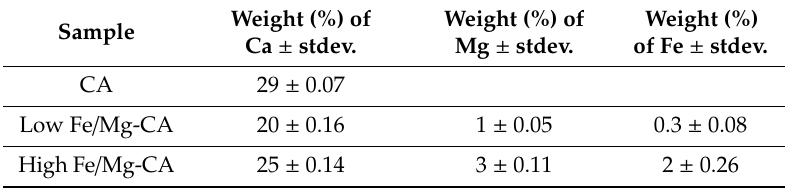
Table 5. Weight (%) of Ca 2 + in CA, and Ca 2 + , Fe 3 + and Mg 2 + in both low and high Fe / Mg-CA